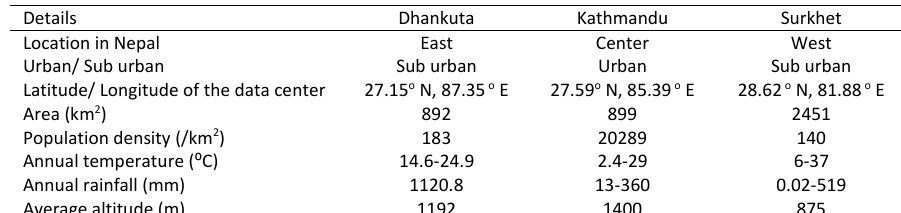
Table 1: Detail about the three study sites Table 1. Detail about the three study sites